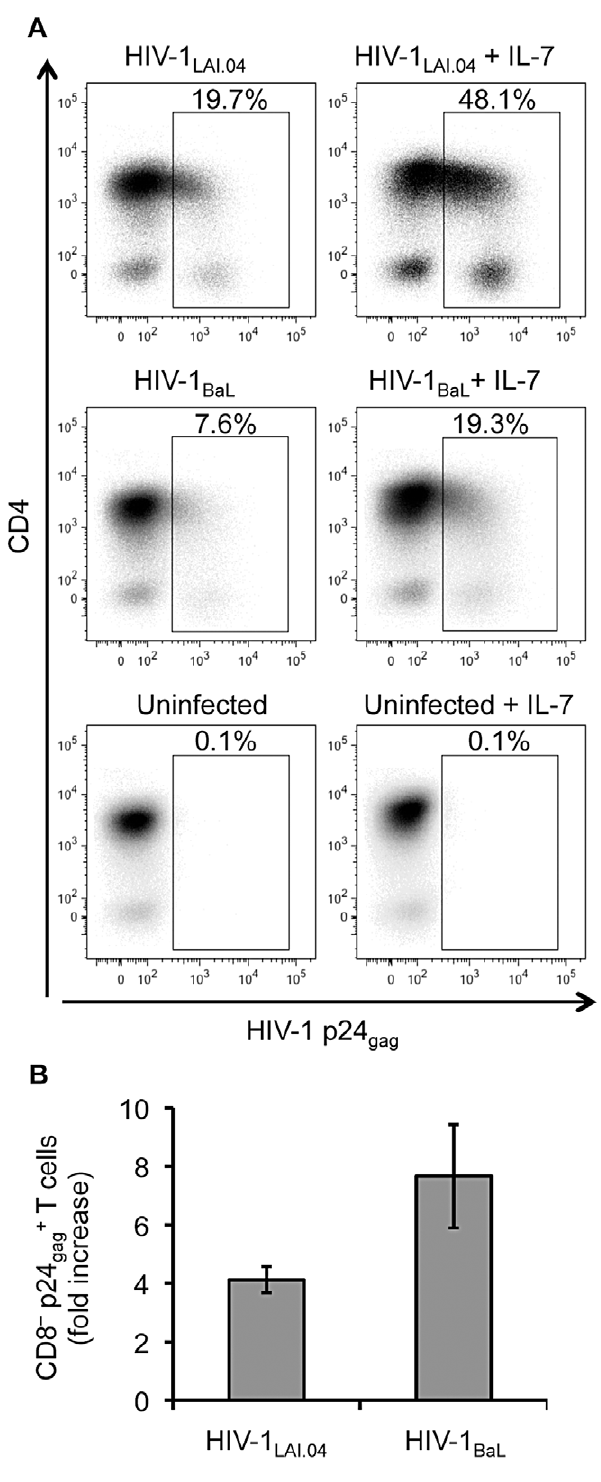
Figure 2. IL-7 increases the number of HIV-1-infected CD4 + T cells in lymphoid tissue explants. ( A ) Presented are dot plots for CD4 + T cells isolated from HIV-1-infected tissue blocks treated or not treated with IL-7 25 ng/mL from a representative donor on day 9 post infection. The amount of HIV-1-infected CD4 + (CD8 2 p24 gag + ) T cells is expressed as percentage of CD3 + CD8 2 cells. Upper panel: HIV-1 LAI.04 , middle panel: HIV-1 BaL , lower panel: uninfected control. ( B ) Presented are the average increases in the numbers of HIV-1-infected CD4 + T cells isolated from tissue blocks infected with HIV-1 LAI.04 ( n =8) or HIV-1 BaL